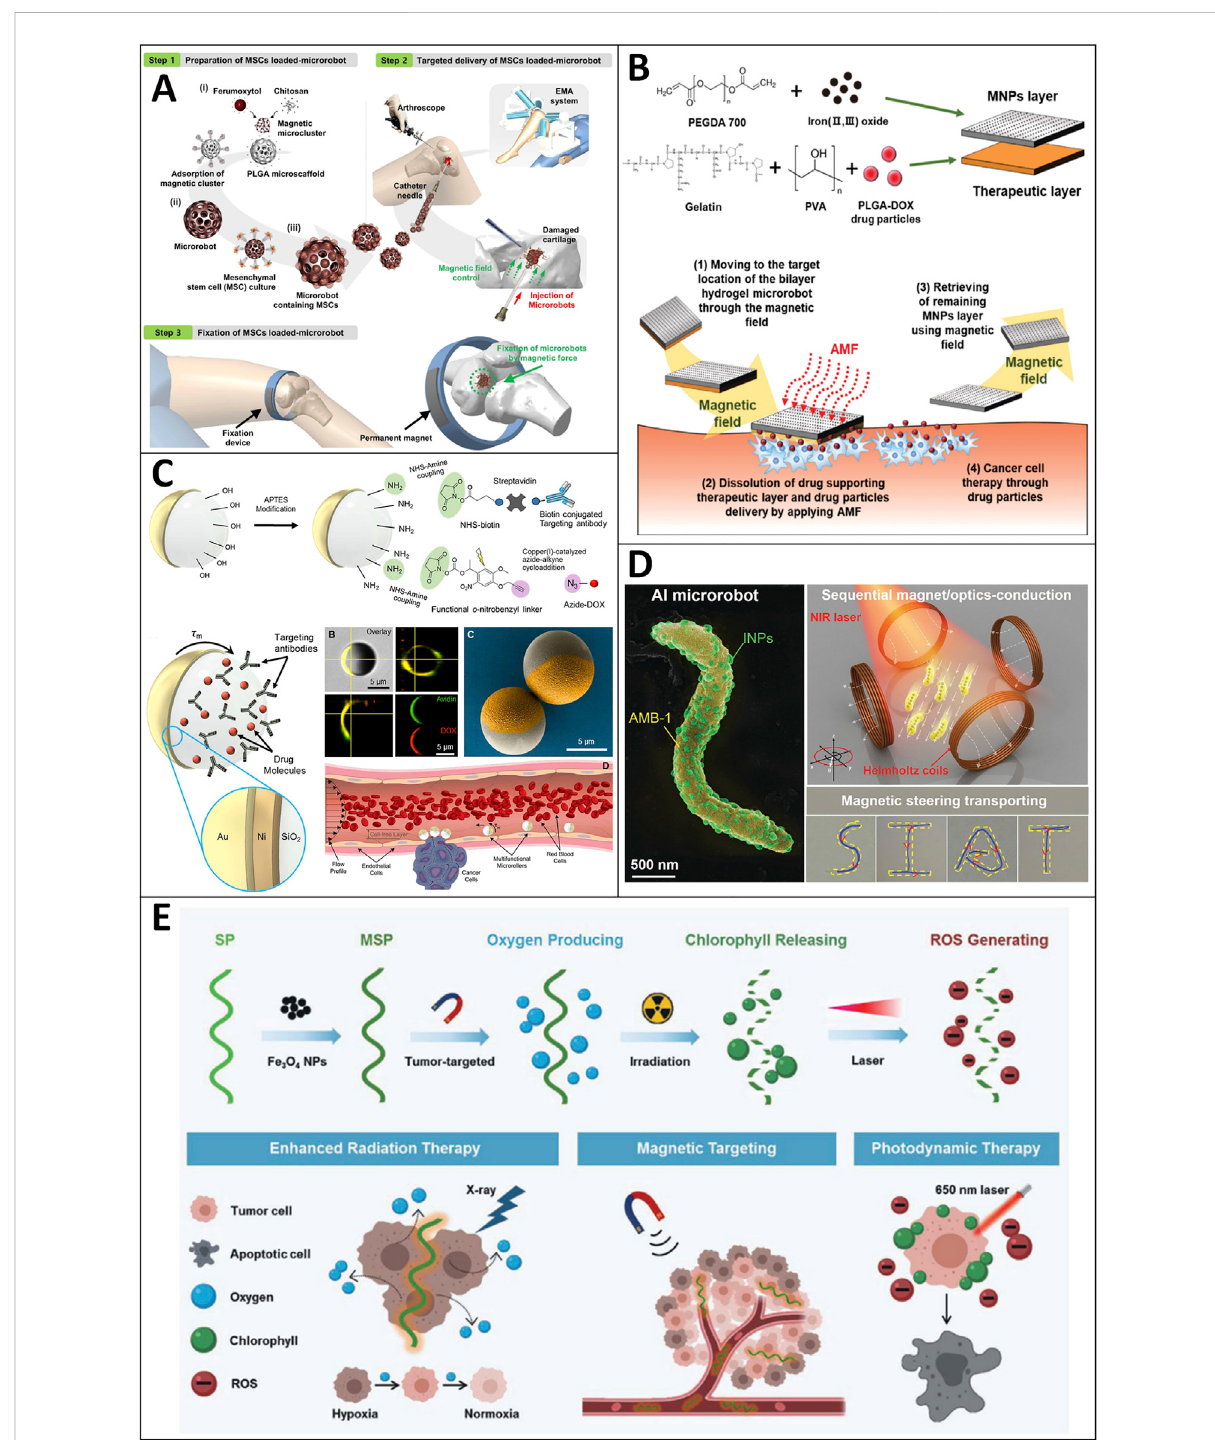
FIGURE 7 Motile drug delivery by magnetic- fi eld-powered MNRs. (A) Human adipose-derived mesenchymal stem cell (hADMSC)-based medical microrobot. (Go et al., 2020) Copyright 2020. Reproduced with permission from American Association for the Advancement of Science. (B) Bilayer hydrogel sheet-type intraocular microrobots. (Kim et al., 2020) Copyright 2020. Reproduced with permission from John Wiley and Sons. (C) Leukocyte-inspiredmultifunctionalmicrorollers.(Alapanetal.,2020)Copyright2020.ReproducedwithpermissionfromAmericanAssociation for the Advancement of Science. (D) Sequential magneto-actuated and optics-triggered biomicrorobots. (Xing et al., 2021) Copyright 2021. Reproduced with permission from John Wiley and Sons. (E) Photosynthetic biohybrid nanoswimmers. (Zhong et al., 2020) Copyright 2021. Reproduced with permission from John Wiley and